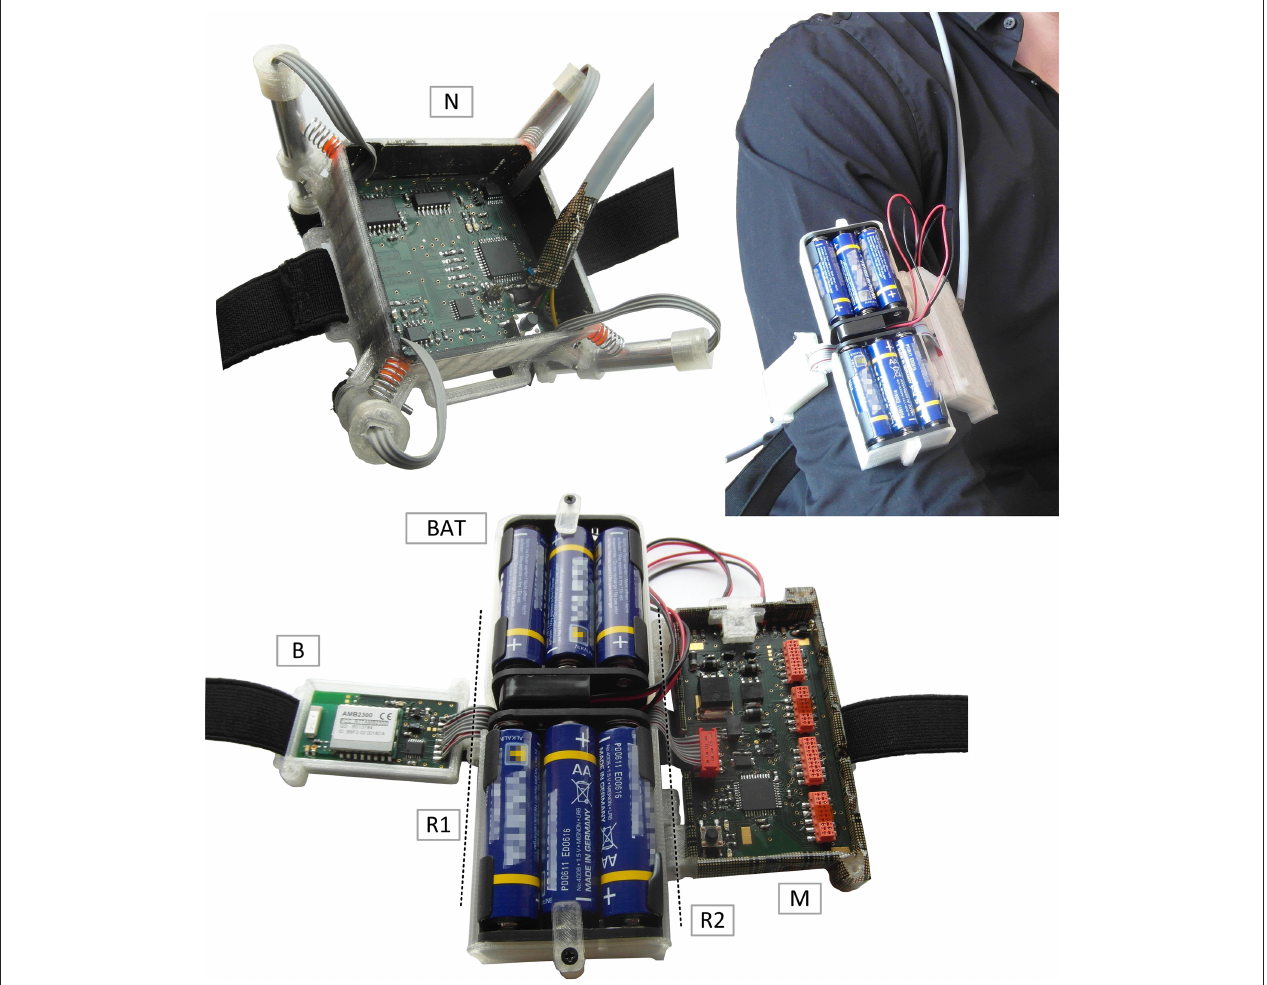
FIGURE 5 | Final System. (N): single 4 channel fNIRS module. Top right/bottom: Chained mainboard module. B, bluetooth module; BAT, batteries; R1/R2, Rotatory joints; M,